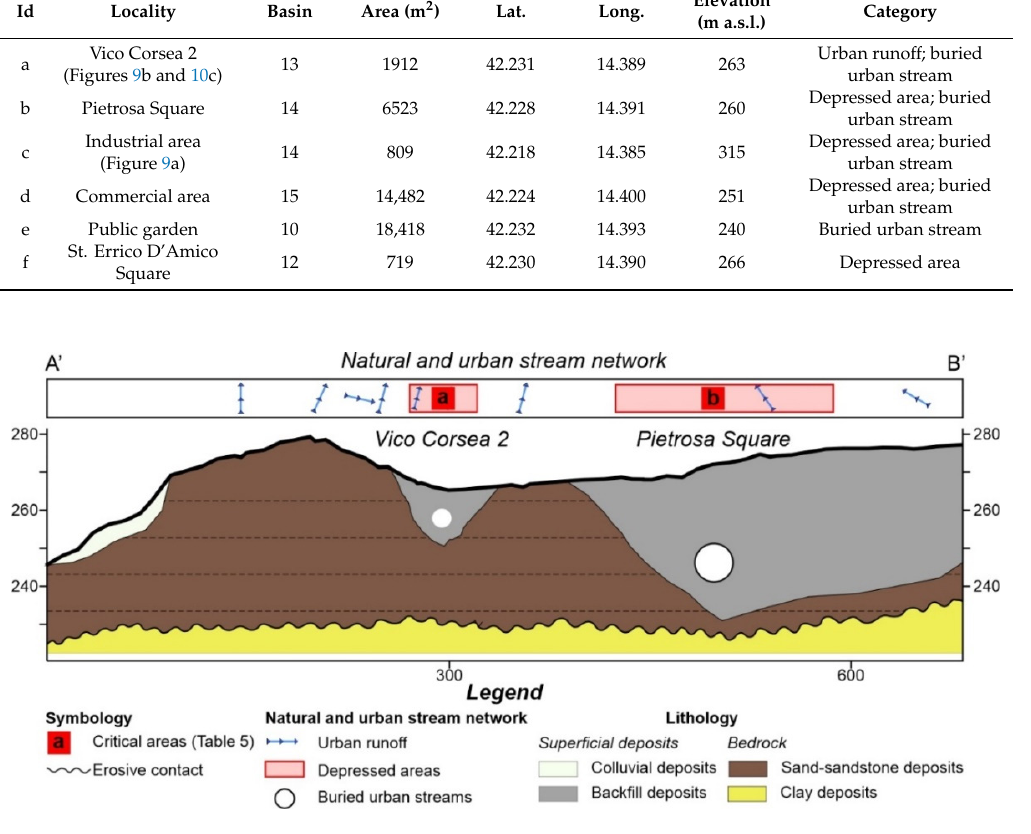
Figure 11. Schematic geomorphological cross-section of the urban area of Lanciano (section trace in Figure 10c; vertical exaggeration 3×), the natural and urban stream network, and urban critical areas (Table 5). The section results to be an enlargement of the central part (urban area of Lanciano) of the cross-section AB of Figure